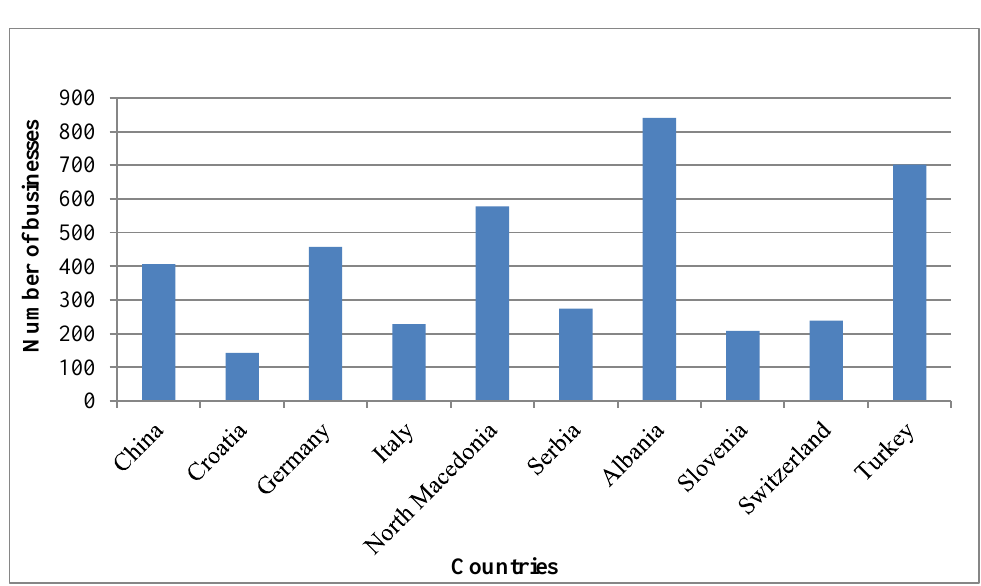
Fig. 4. Number of businesses with foreign owners by top 10 countries,